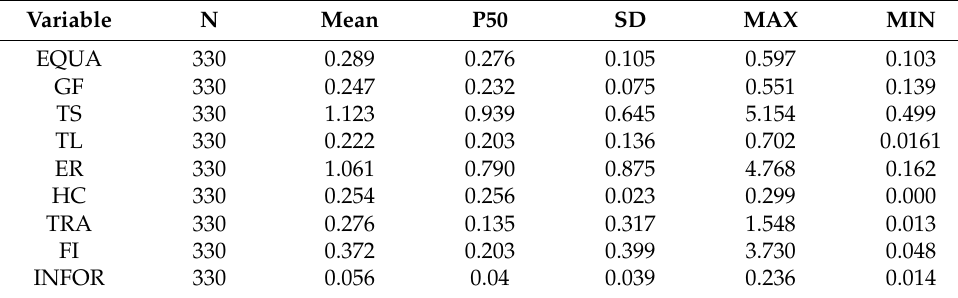
Table 3. Descriptive statistics of the